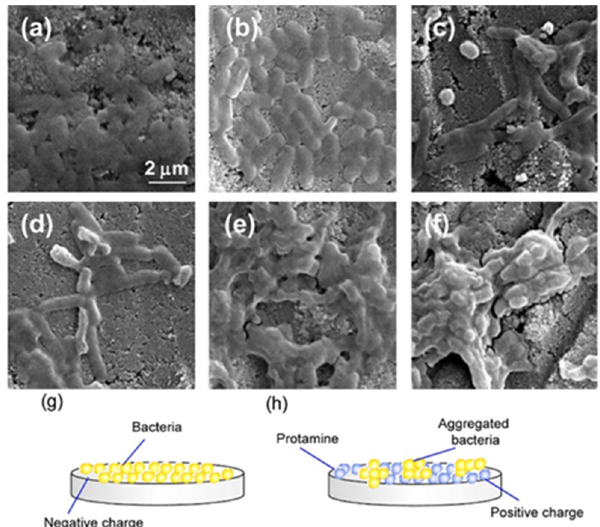
Figure 4. SEM images of E. coli cells on the surface of protamine/HAp discs. E. coli cells cultured on various concentrations of protamine/HAp discs: ( a ) 0 (HAp), ( b ) 125, ( c ) 250, ( d ) 500, ( e ) 1000, and ( f ) 2000 μ g·mL − 1 for 24 h were observed by SEM. Bar indicates 2 μ m. Schematic diagram of the adhesion of bacteria to HAp ( g ) or protamine/HAp disc ( h ).